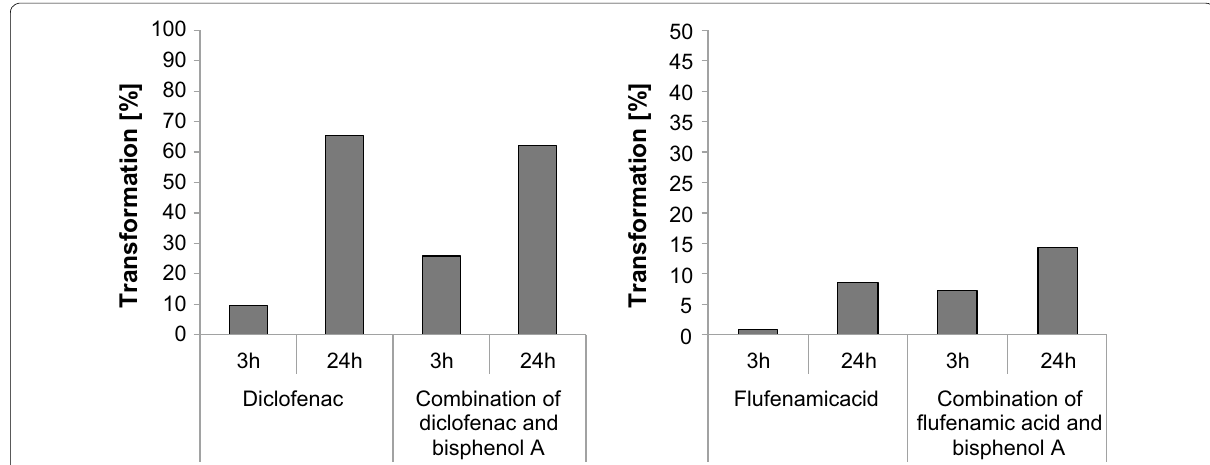
Fig. 2 Laccase-mediated transformation [%] of DCF or FA treated individually or in combination with BPA in phosphate buffer (concentration of reactants 0.1